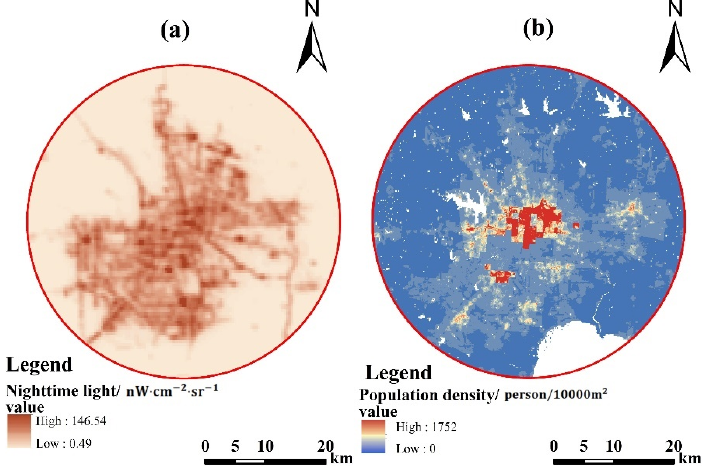
Figure 2. The nighttime light and population density of study area. ( a ) Spatial patterns of nighttime light; ( b ) spatial patterns of population density.